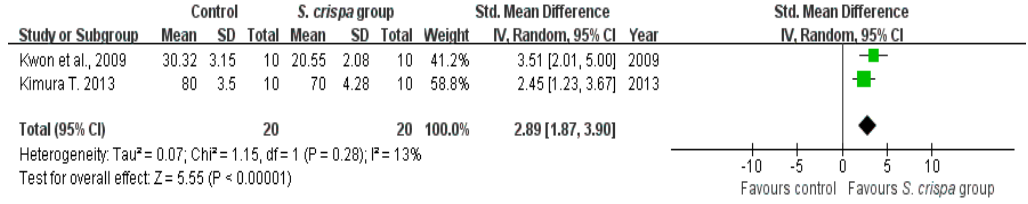
Figure 11. Comparison of DPPH radical scavenging activity between control and S. crispa groups.